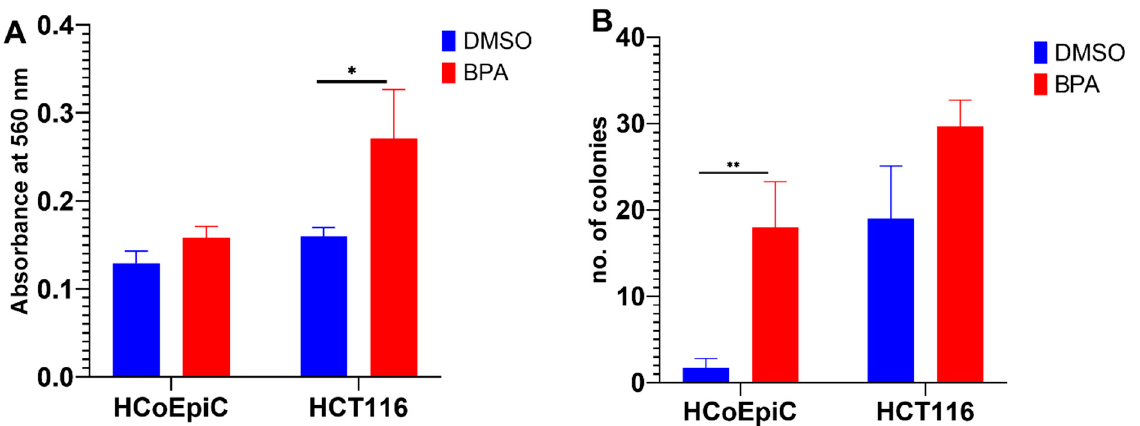
Figure 2. Cellular transformation after prolonged low-dose exposure to BPA. ( A ) Collagen invasion assay of HCoEpiC and HCT116 cell lines exposed to BPA for two months as compared to the base line invasion of the control (vehicle-exposed) cells. The bars represent the quantitative evaluation of cell invasion as measured by dye elution and spectrophotometric reading at 560 nm. ( B ) Colony formation in soft agar. HCoEpiC and HCT116 cell lines, exposed to BPA or the vehicle (DMSO) for two months, were seeded on soft agar in 6-well plates for 3–4 weeks. The cells were fixed and stained, and the number of colonies was counted in 5 × 100 power fields. The data shown are means ± SEMs, and * p < 0.05 and ** p < 0.01, with n = three biological replicates.